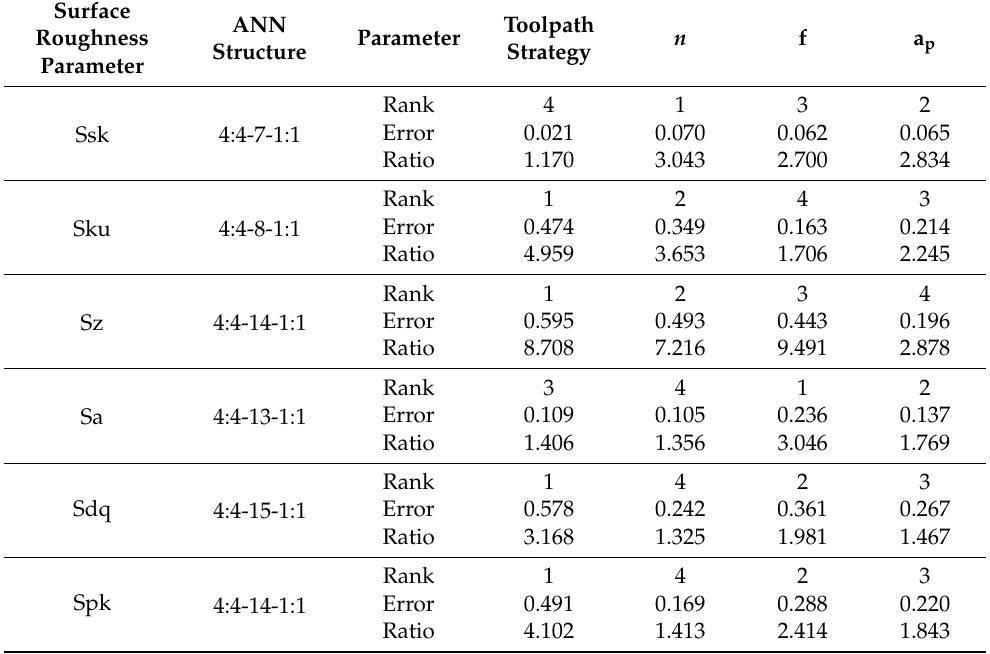
Table 8. The results of sensitivity analysis for surface roughness parameters measured on the outer side of the